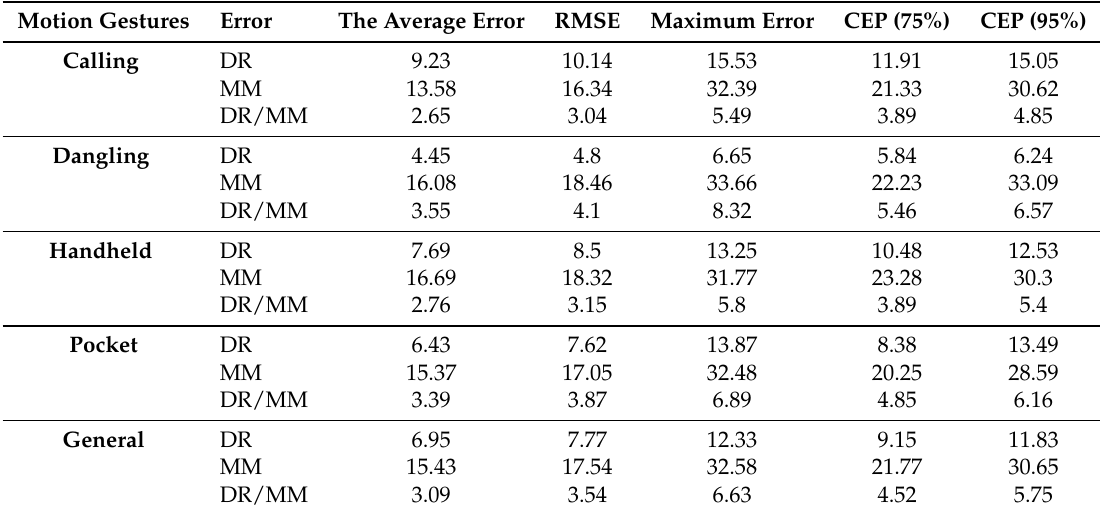
Table 1. Position errors for DR, MM and DR/MM (m) in teaching building.